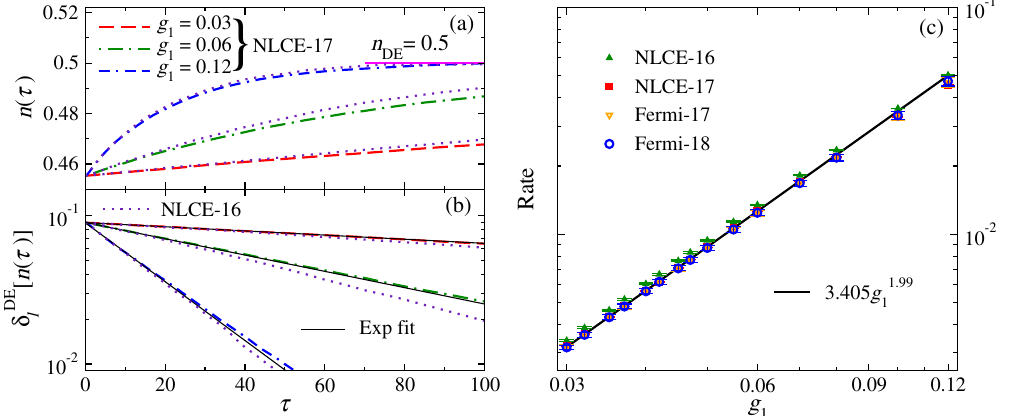
ˆ H → ˆ H τ Þ and (b) dynamics FIG. 1. Dynamics of the particle filling after quantum quenches 1 . (a) Dynamics of the particle filling n ð I of the “ distance ” to equilibrium δ DE ½ n ð τ Þ(cid:2) ; see Eq. (52). NLCE results are shown for l ¼ 17 [NLCE-17, see legend in (a)] and l ¼ 16 l (NLCE-16, dotted lines). Straight lines in (b) depict fits to the results for l ¼ 17 in the interval τ ∈ ½ 1 ; 16 (cid:2) and to exponential functions τ (cid:2) . (c) Thermalization rates Γ NLCE ð g 17 in the interval ∝ exp ½ − Γ NLCE 1 Þ (filled symbols) obtained from fits as the ones in (b), for l ¼ 17 ð g 1 Þ ∈ ½ 0 . 03 ; 0 . 12 (cid:2) . Error bars show τ ∈ ½ 1 ; 16 (cid:2) (NLCE-17), and for l ¼ 16 in the interval τ ∈ ½ 1 ; 6 (cid:2) (NLCE-16), reported for g 1 95% confidence bounds for the fits. The straight line is the result of a fit to Γ NLCE 17 ð g 1 Þ ∝ g β 1 for g 1 ∈ ½ 0 . 03 ; 0 . 06 (cid:2) . The open symbols show the rates Γ Fermi ð g 1 Þ obtained evaluating Fermi ’ s golden rule [see Eqs. (53) and (54)] using full exact diagonalization in chains with L ¼ 18 (Fermi-18) and L ¼ 17 (Fermi-17), and periodic boundary conditions. The error bars show the standard deviation from averages over different choices of Δ E and τ (see Appendix D).